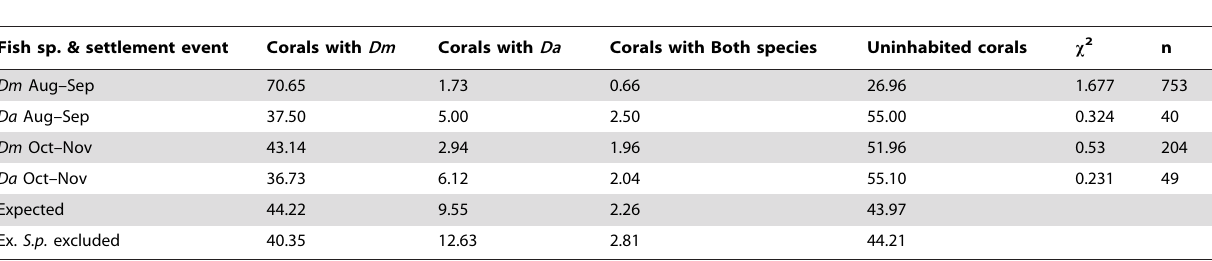
Table 2. Comparison of the distribution of settlers of D. marginatus and D. aruanus among corals with and without conspecific adults presented as the percent of settlers observed on each coral